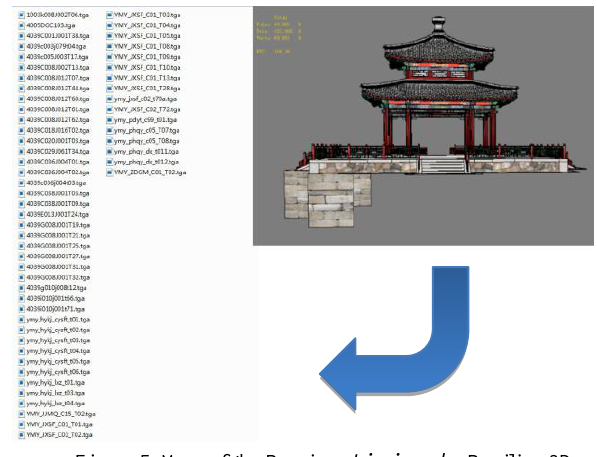
Figure 5. Map of the Previous Liuxiangzhu Pavilion 3D Model